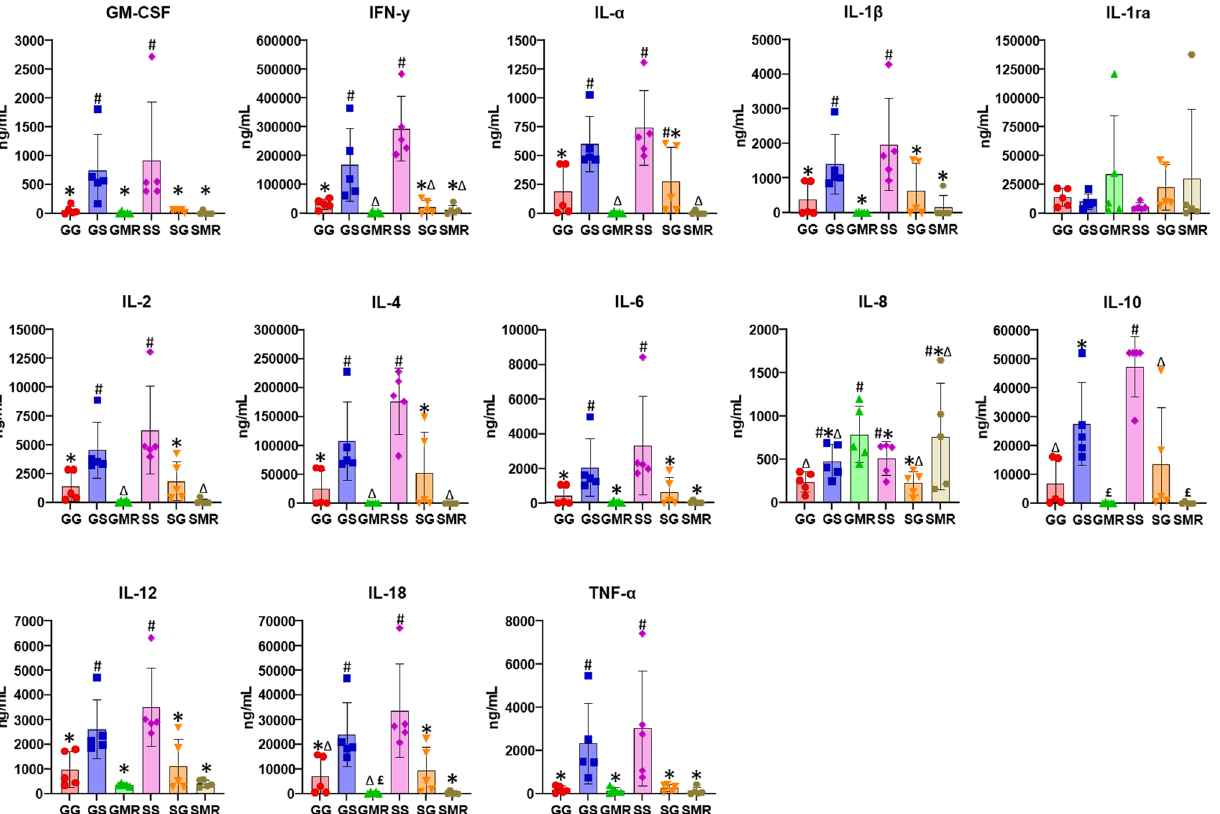
Figure 4. Effect of sow parity and their colostrum on piglet serum cytokine concentration (ng/mL) at 24 h after birth. Error bars represent the standard error of the mean (± SEM). Different superscripts indicate significant differences among groups ( P ≤